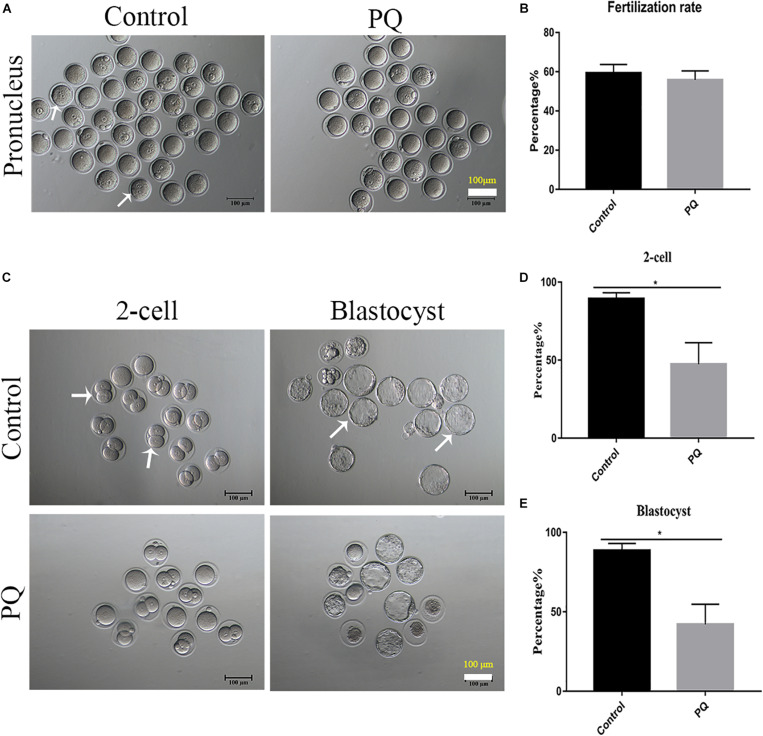
Paraquat (PQ) decreases the embryonic developmental potential in mice. (A) Representative images of pronuclei after in vitro fertilization (IVF) in the control and PQ-treated groups. The white arrow indicates the zygote with pronucleus. Scale bar = 100 μm. (B) The percentage of IVF rates in the control and PQ-treated groups. (C) Representative images of two-cell embryos and blastocysts in the control and PQ-treated groups after mating. The white arrow indicates the representative two-cell embryos and blastocysts. Scale bar = 100 μm. (D,E) The percentage of two-cell embryos and blastocysts in the control and PQ-treated groups after mating. Data are presented as mean ± SEM from at least three independent experiments. ∗P < 0.05.